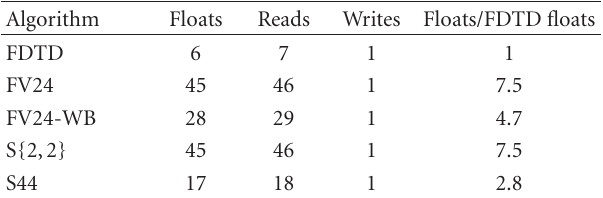
Table 1: Comparison of the theoretical computational costs for the various FDTD algorithms.